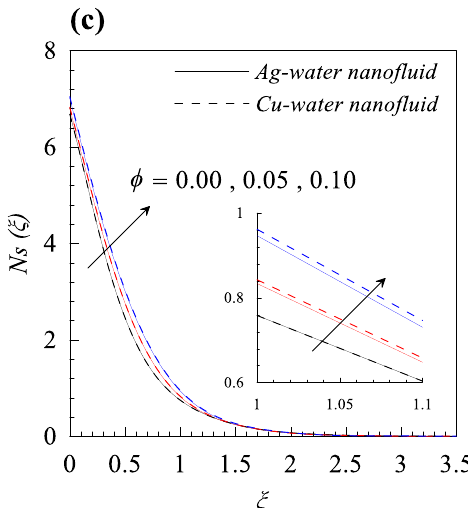
Figure 4. Effects of nanoparticle solid volume fraction φ on ( a ) velocity profile g ’( ξ ), ( b ) temperature distribution θ ( ξ ), and ( c ) entropy generation Ns ( ξ ), when κ = 10, M = 0.2, ε = 0.2, Ec = 0.3, and λ = 0.5.